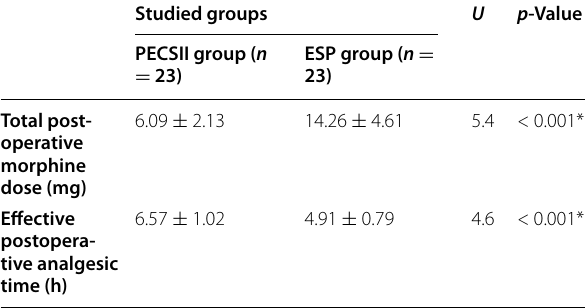
Data were expressed in mean SD. P < 0.01 statistically is significant. ± *Significant for ESP compared to PECSII. U Mann-Whitney test, SD standard deviation, PECSII modified pectoral plane block, ESP erector spinae plane block Table 3 Postoperative visual analog scale of the studied groups at different points of time